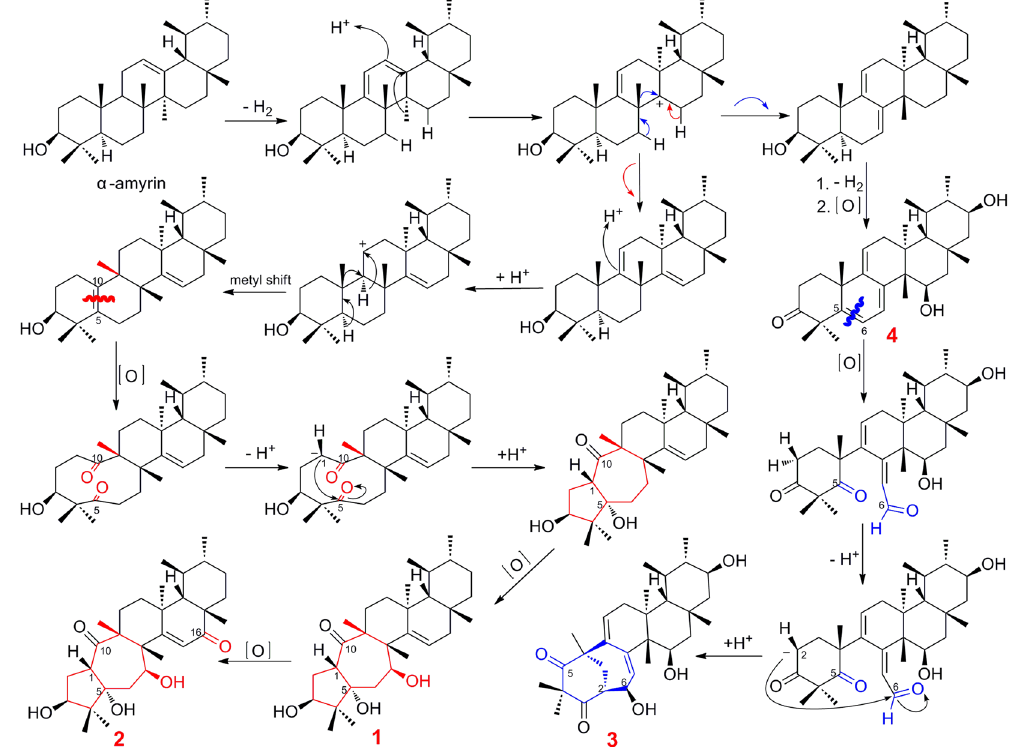
Figure 8. Plausible Biogenetic Pathway of ( 1 ‒ 4 ).